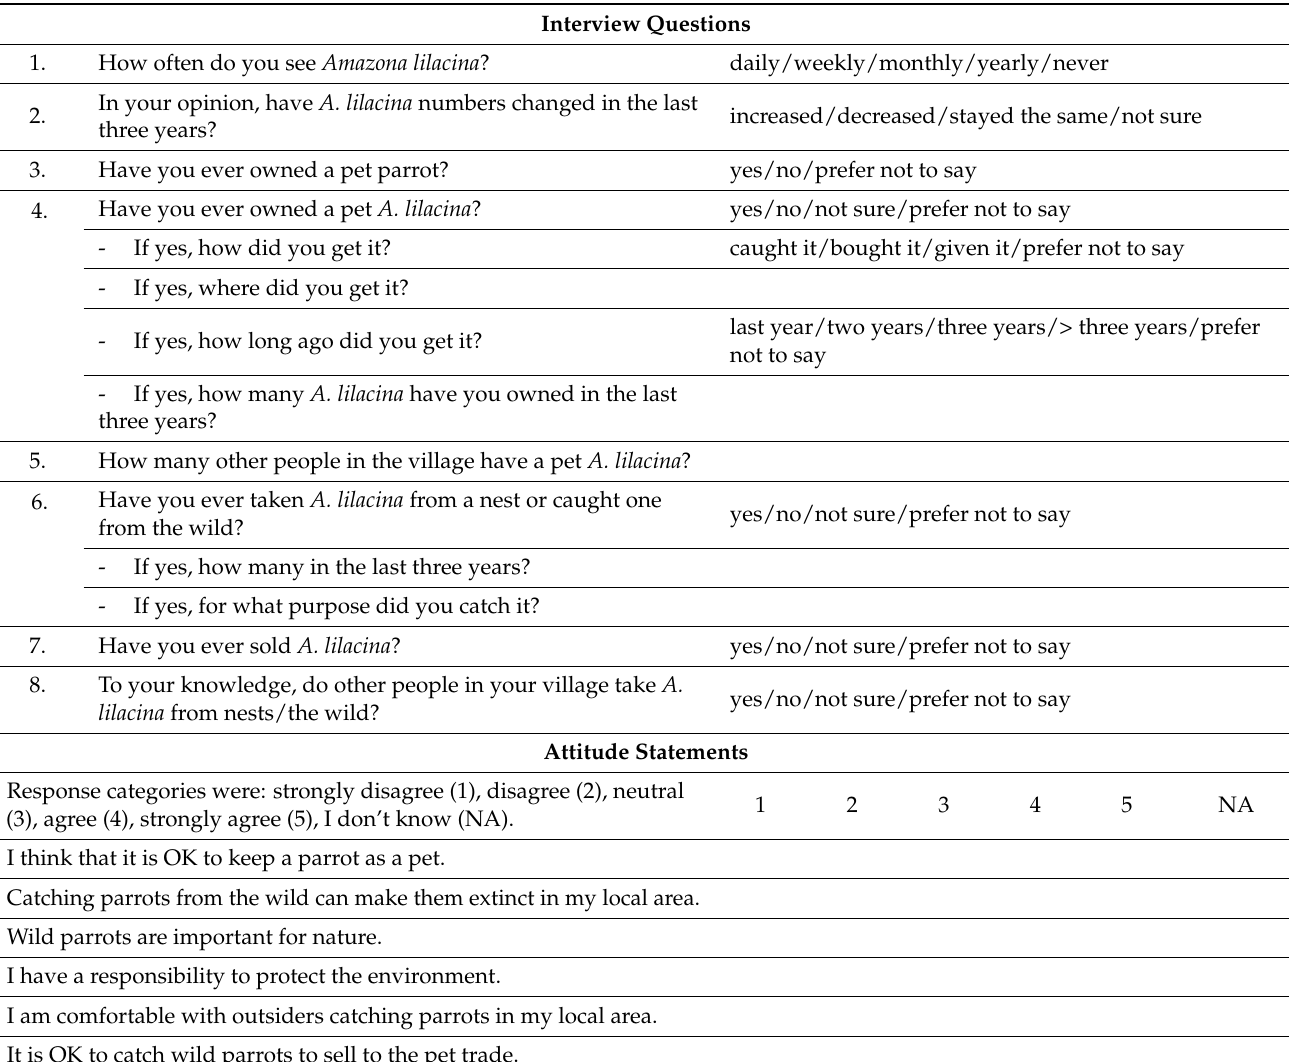
Table 1. Interviews about parrot ownership and capture asking eight questions and seven attitude statements, which were read out aloud by the researcher in Spanish. Interviews were anonymous and participants could decline to answer any